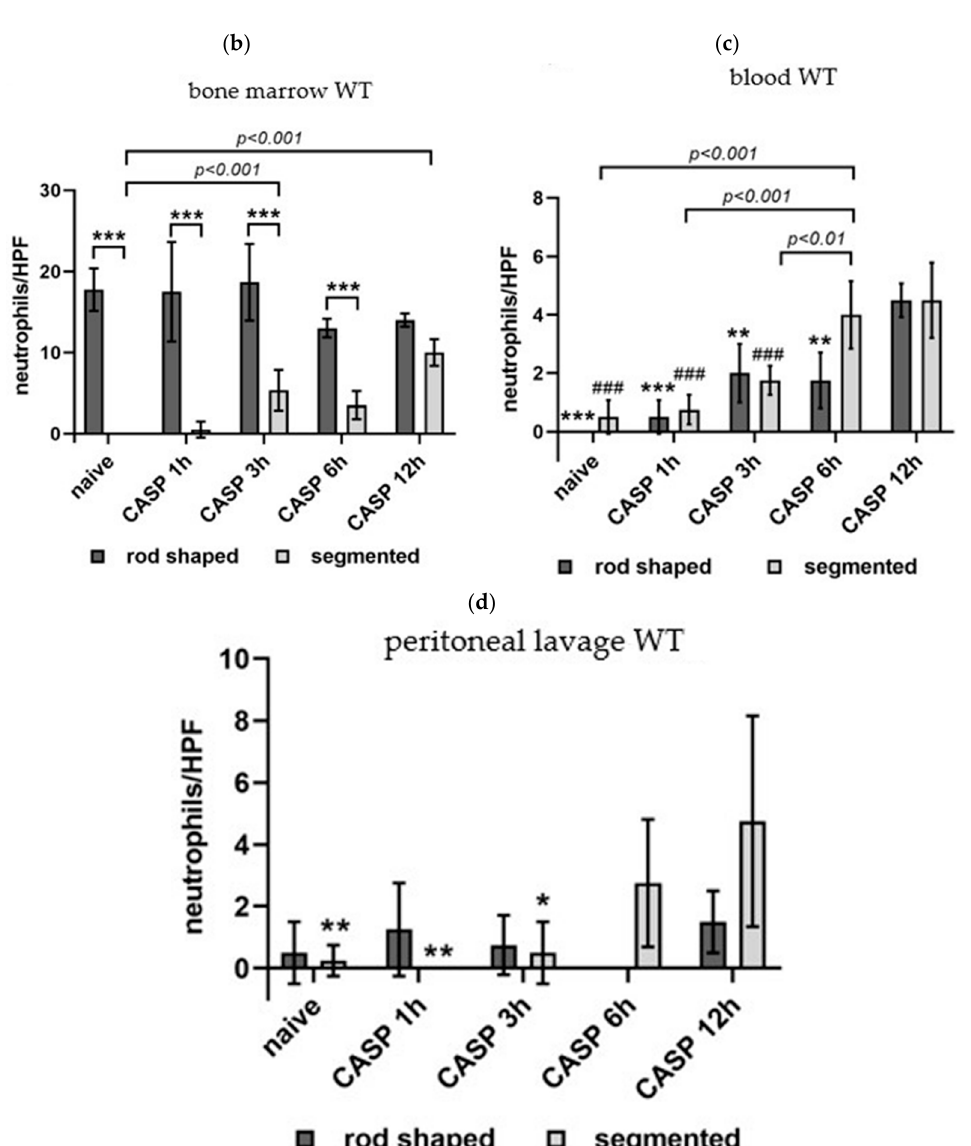
Figure 2. CASP induces a reactive left shift of neutrophil granulocytes . Neutrophil granulocytes of untreated WT and septic WT mice 1 h, 3 h, 6 h, and 12 h after CASP induction were counted in high-power fields (HPF) of smear slides ( n = 5). ( a ) Representative smear slides of naïve WT and septic WT after 12 h CASP stained with Hemacolor (original magnification 400×). ( b ) Maturation of neutrophil granulocytes during CASP in BM (*** p < 0.001), ( c ) blood (* p < 0.01 and ** p < 0.001 versus WT CASP 12 h rod-shaped; ### p < 0.001 versus WT CASP 12 h segmented), and (d) peritoneal lavage (* p < 0.05 and ** p < 0.01 versus WT CASP 12 h segmented). Graphs show mean ± SEM.